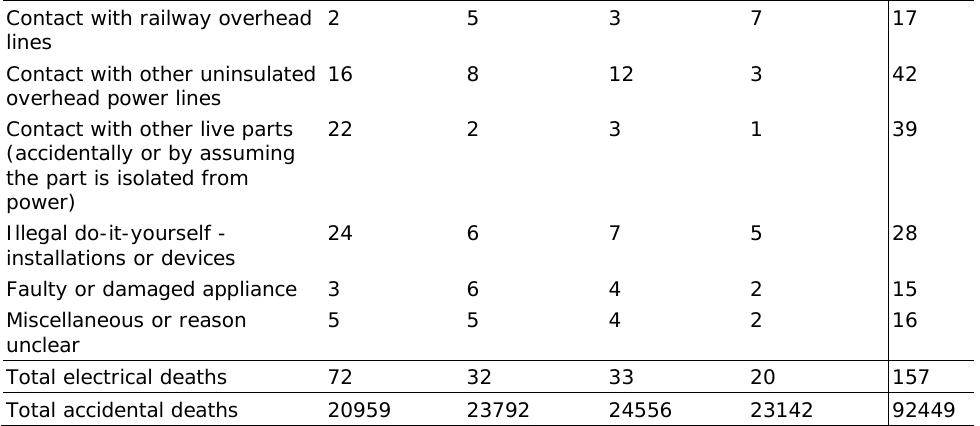
Table 2. Finnish electrical accidents analysed and classified into six